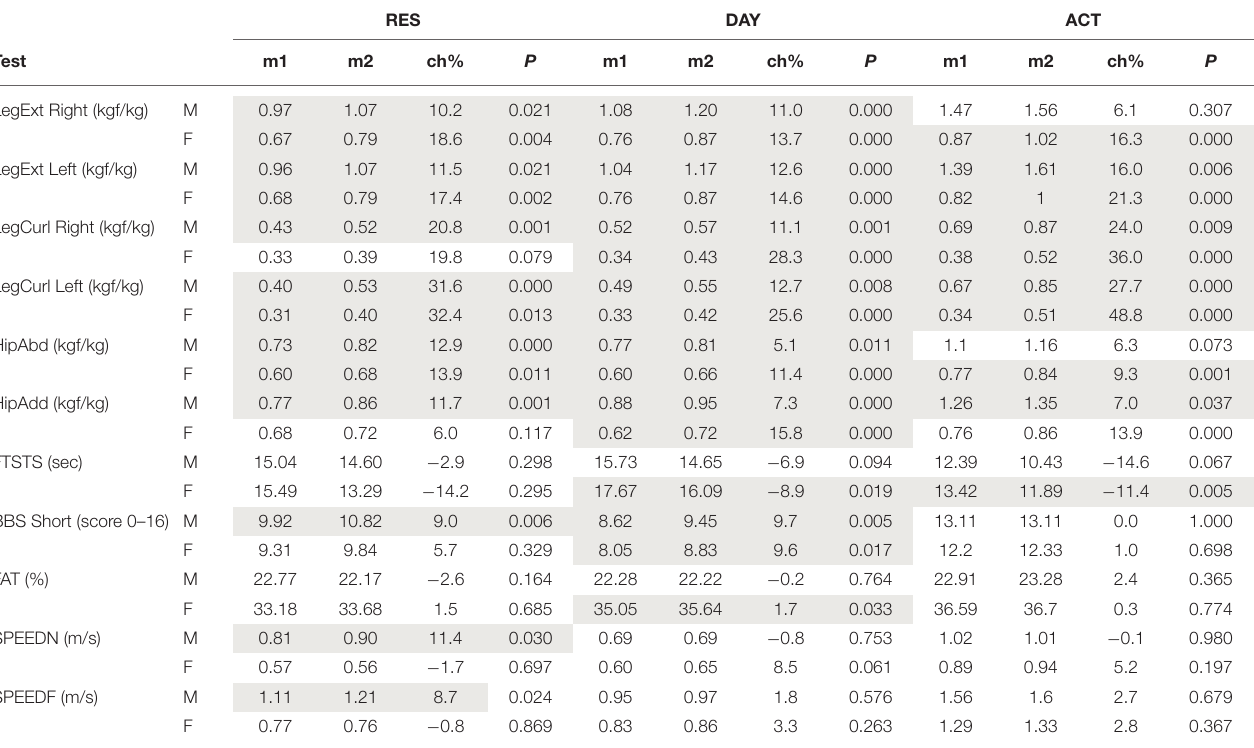
TABLE 2 | Pre-post changes for tests ( N =